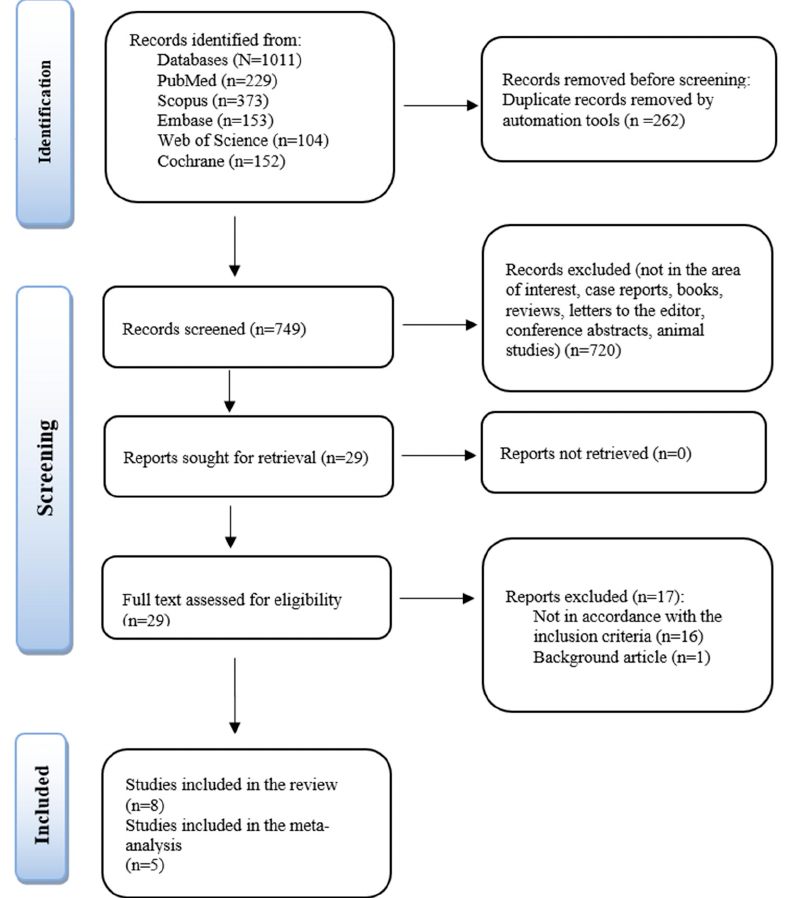
Figure 3. PRISMA illustration of the chosen